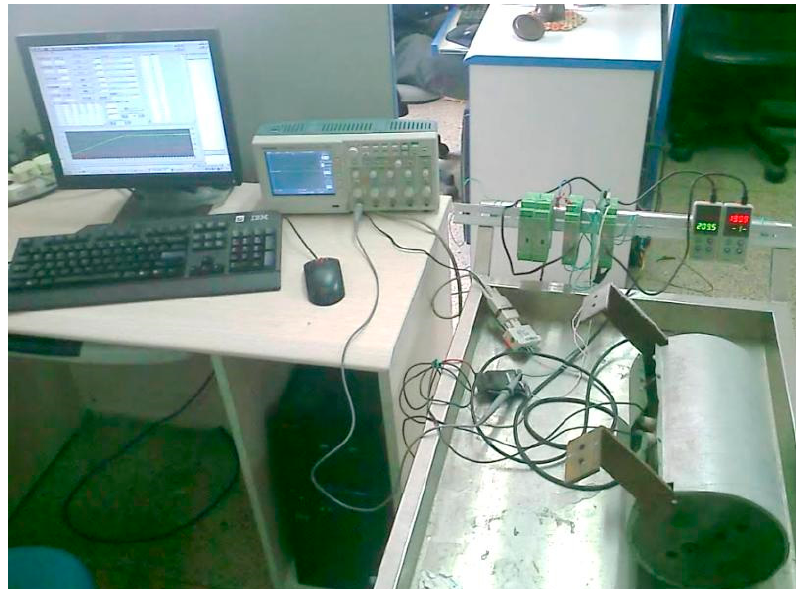
Figure 3. Heating control system with E-PID (expert system based proportion integration differentiation controller) and F-PID (fuzzy calculation based proportion integration differentiation controller) methods.